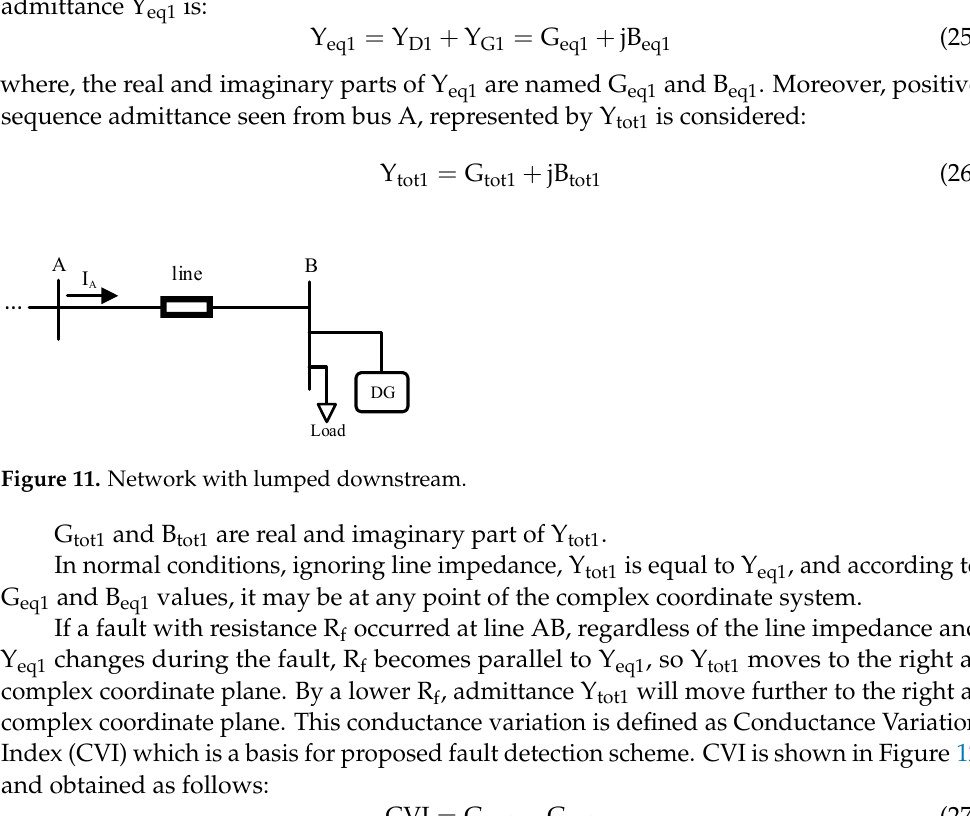
Figure 10. Flowchart of the proposed main protection scheme.